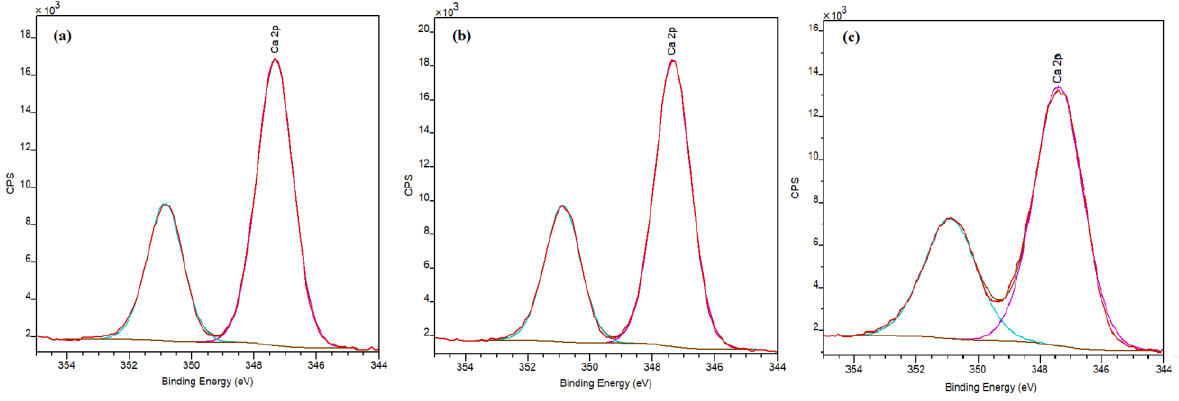
Figure 9. XPS of Ca 2p spectra for ( a ) HAp-D, ( b ) HAp-S, and ( c ) HAp-R. For all HAps, the O 1s envelope (not shown) was fitted with two peaks at 531.1 eV and 532.6 eV, attributed to O-Ca and O-P (or O-H) in HAps structure, respectively [35,36].